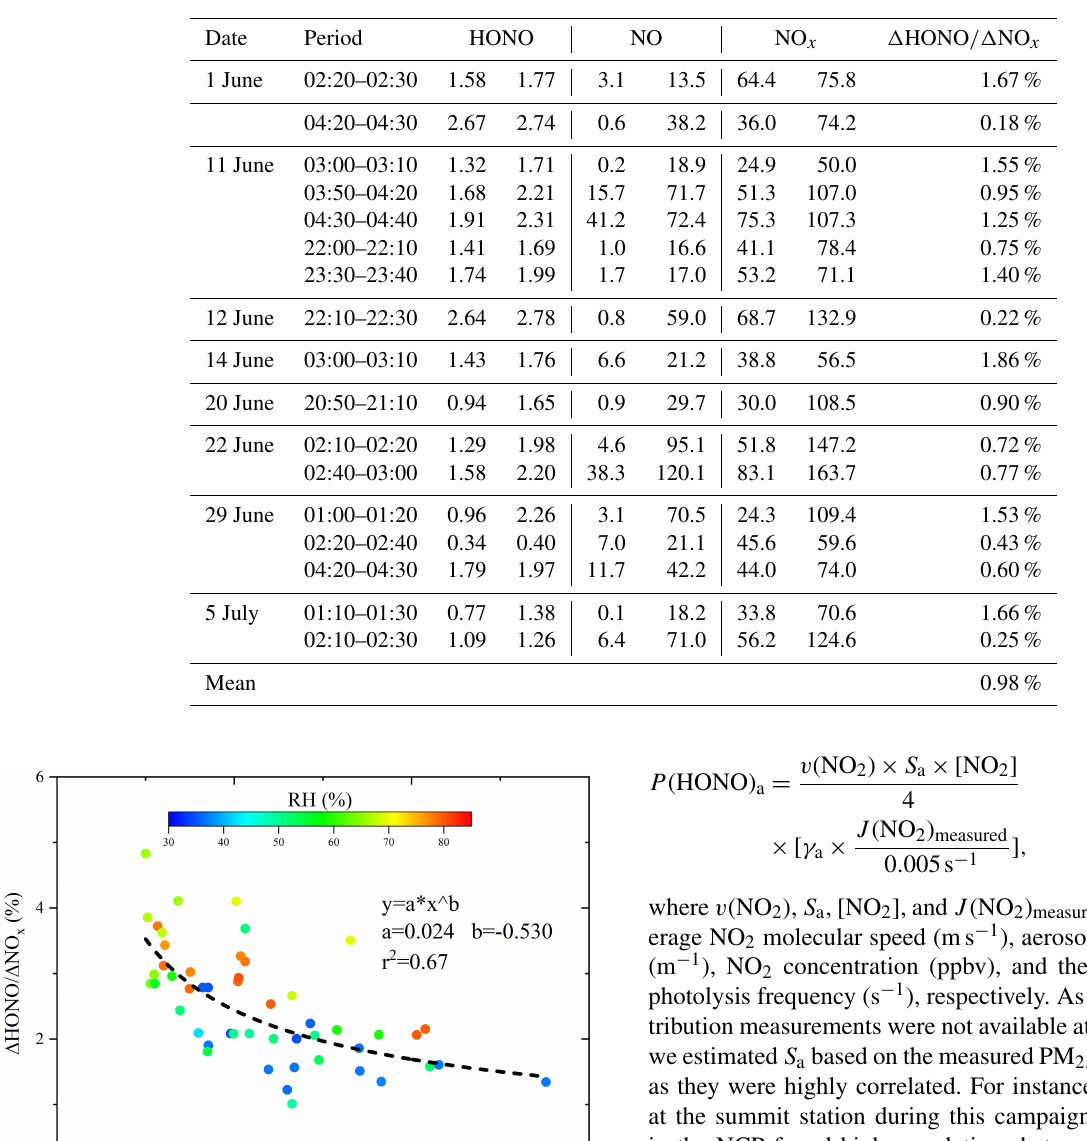
Table 4. (cid:49) HONO /(cid:49) NO x ratios determined from nighttime (19:00–04:50) data of the campaign. Concentrations (ppbv) of HONO, NO, and NO x at the start and the end of each plume of fresh emissions are also shown.